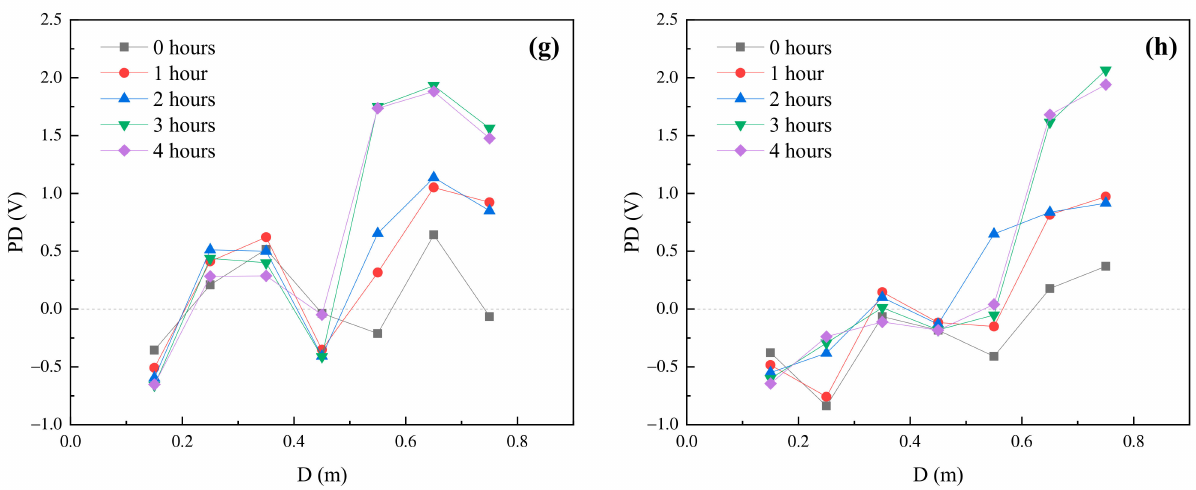
Figure 7. Distributions of PD for different survey lines on the four dam models under seepage. ( a ) L1 on DM 1; ( b ) L2 on DM 1; ( c ) L1 on DM 2; ( d ) L2 on DM 2; ( e ) L1 on DM 3; ( f ) L2 on DM 3; ( g ) L1 on DM 4; ( h ) L2 on DM 4. The D refers to the distance to dam crest along the downstream slope. The black square symbols, the red circle symbols, the blue triangle symbols, the green inverted triangle symbols, and the purple rhombus symbols represent the PD for 0 h, 1 h, 2 h, 3 h, and 4 h after filling the reservoir,